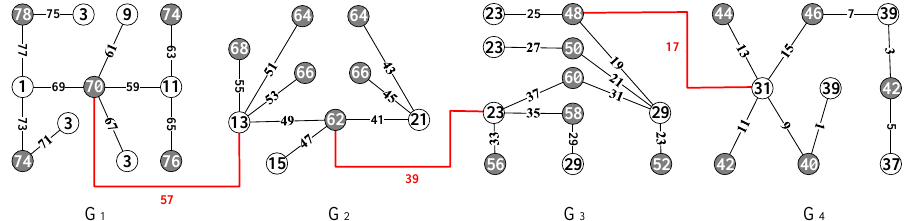
Figure 3. A single-series graph, made by the four graphs shown in Figure 1, admits a set-ordered odd-graceful total